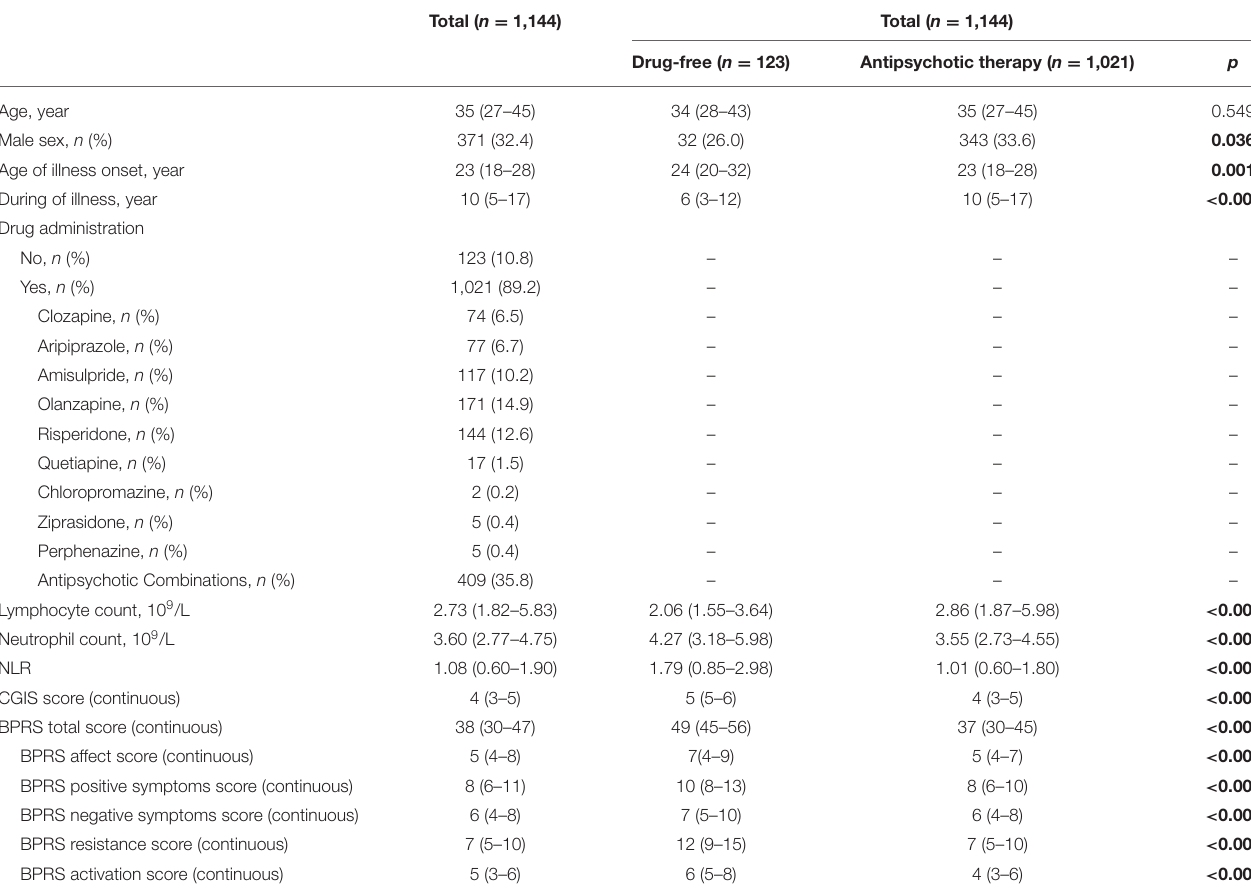
TABLE 1 | Demographic and clinical characteristics of the patients with schizophrenia.